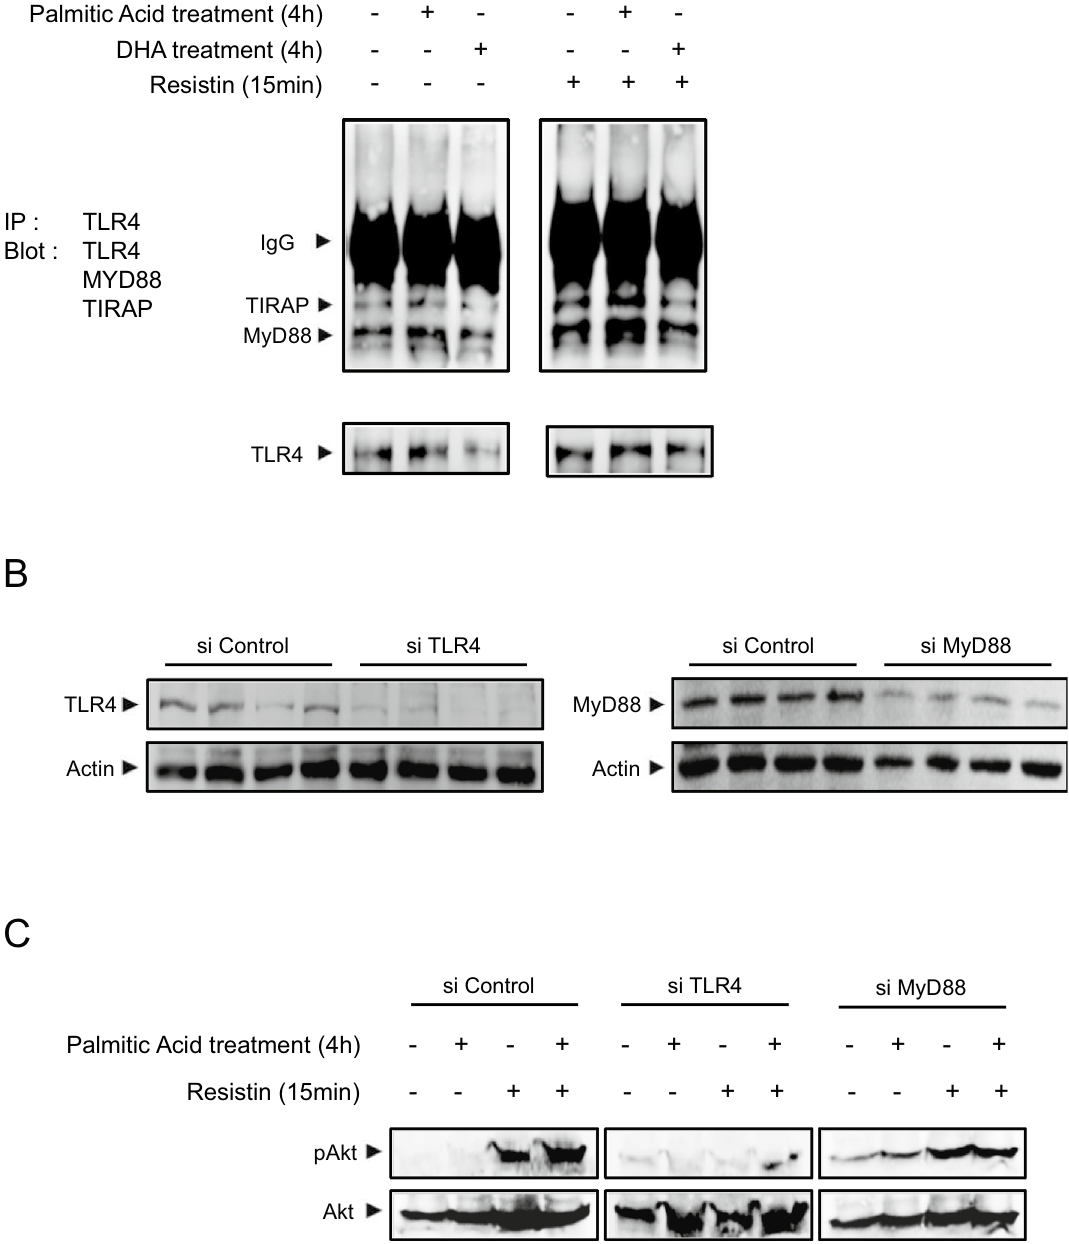
Figure 7. Palmitic acid increased resistin-dependent TLR4/MYD88/TIRAP association. (Panel A ) Immunoprecipitation/Immunoblot (IP/IB) showing the association of TLR4 with MyD88 and TIRAP was analyzed in human SH-SY5Y neuroblastoma cells following treatment with palmitic acid or DHA and in response to resistin by Western blot using adequate antibodies. All blots are from the same membrane. Each experiment has been performed in triplicates as technical replicates. (Panel B ) Human SH-SY5Y cells were transfected with scramble (Control siRNA), siTLR4 or siMyD88 and then TLR4 and MyD88 expression were measured by Western blot normalized to actin, for each antibody different blots were used. Each experiment has been performed in triplicates as technical replicates. (Panel C ) Palmitic acid, resistin or placebo either treated these transfected cells and then Western blots were performed using anti-pAkt or Akt. These blots were performed in independent membranes. Each experiment has been performed in triplicates as technical